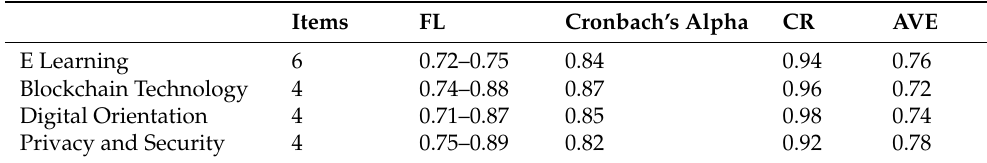
Table 1. CR, factor loading and average variance extracted.